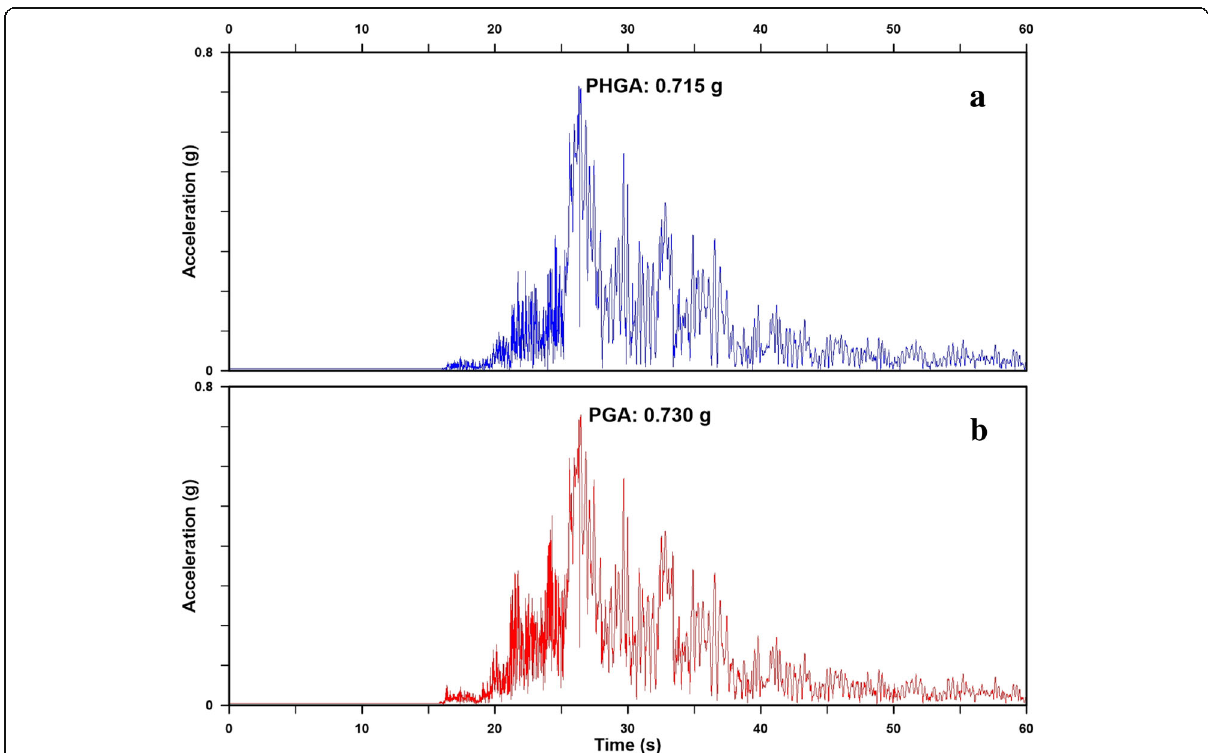
Fig. 8 Synthetic ground accelerations of two dimensions (EW and NS) and three dimensions (EW, NS and UD) observed by a K-NET station (HKD128) in Iburi earthquake. a Horizontal ground acceleration (synthesis of EW and NS directions). b Total ground acceleration (synthesis of EW, NS and UD directions). The ground acceleration data are derived from the National Research Institute for Earth Science and Disaster Prevention